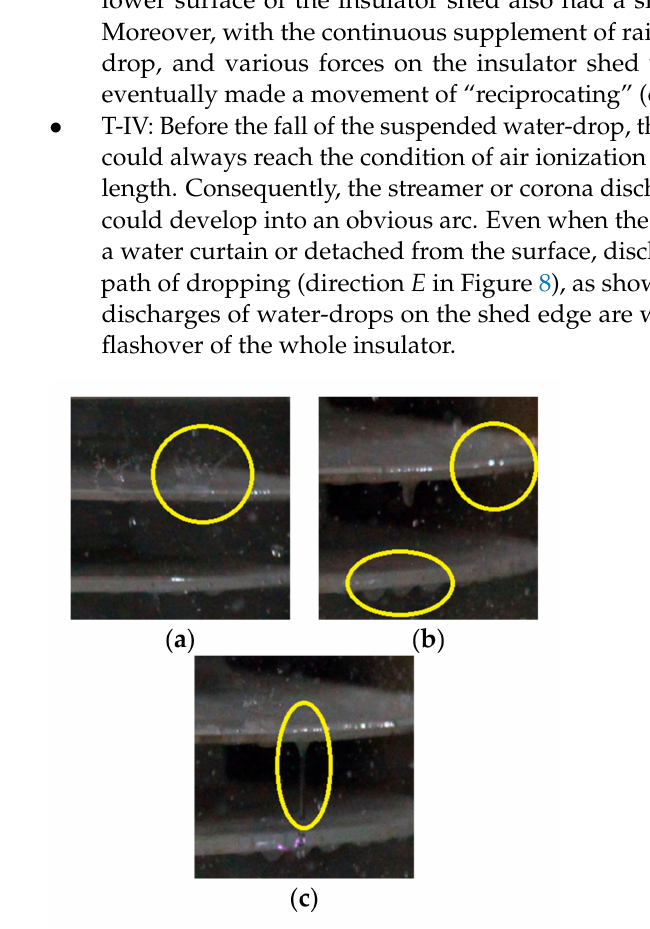
Figure 9. The moment of water-drop: ( a ) on the upper Surface; ( b ) at the edge; ( c ) hanging on the lower surface and elongated.